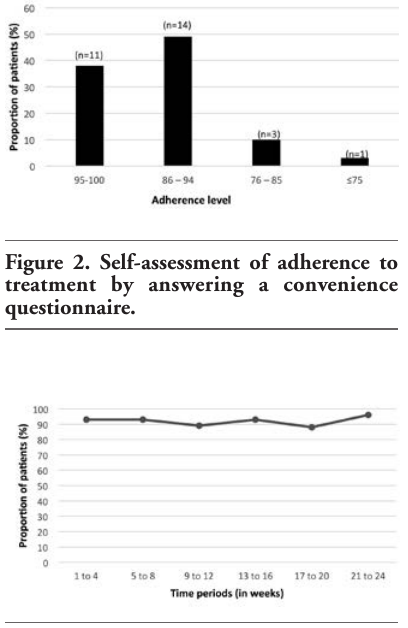
Figure 3. Proportion of patients with spec- ified self-reported adherence within 4